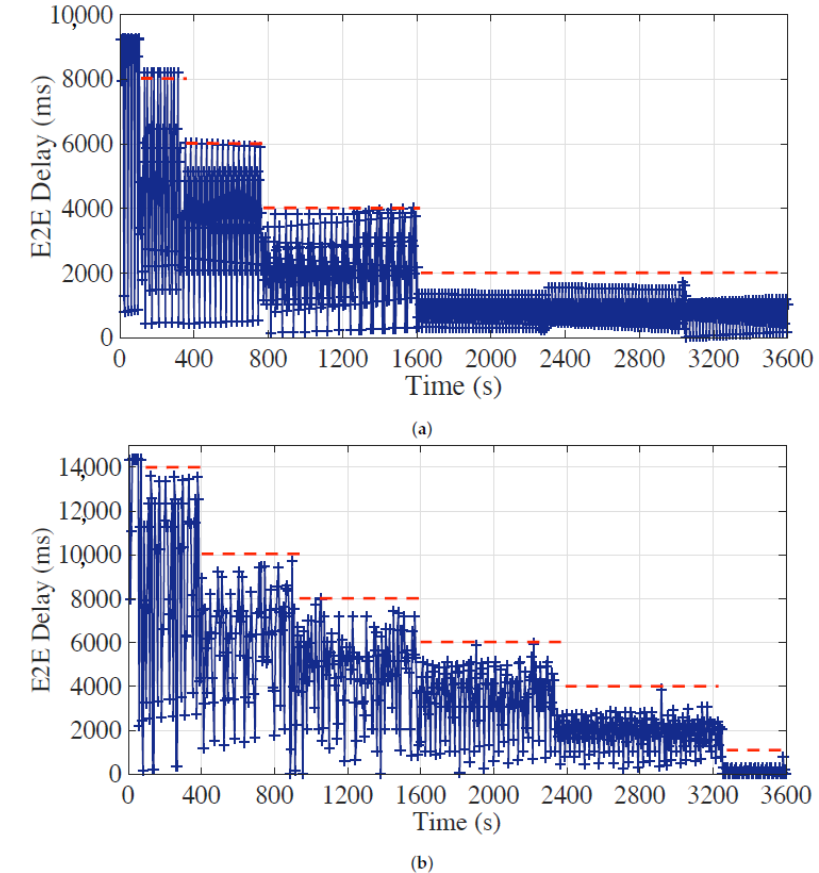
Figure 9. End-to-end (E2E) delay performance of the optimal bundling under dynamic E2E delay requirement setting and the maximum bundling number of ( a ) 10 and ( b )